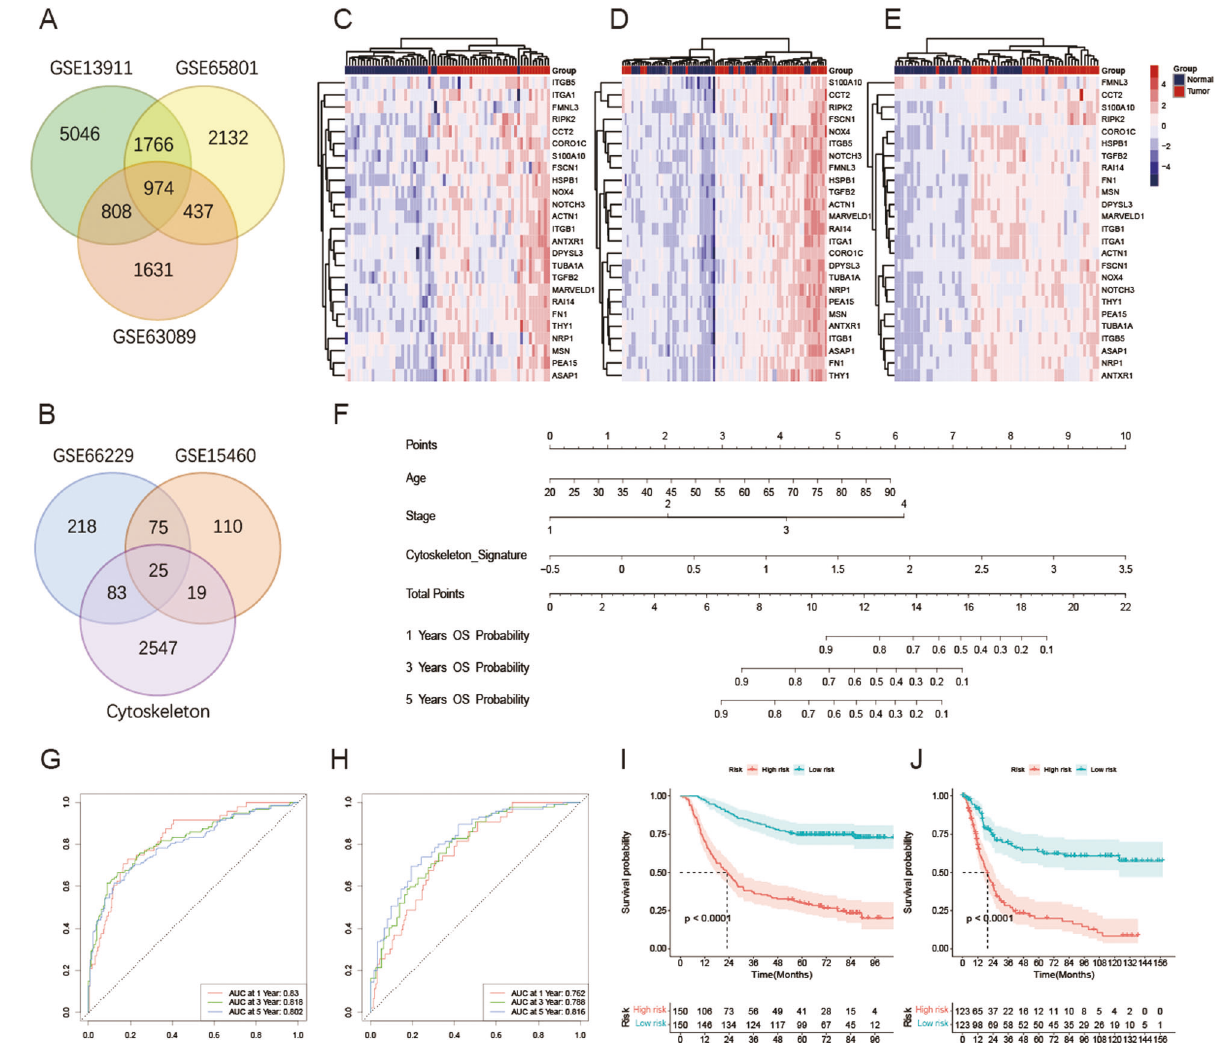
Fig. 1 Extraction of cytoskeleton-related gene signature and construction of cytoskeleton-related risk scoring model. A Co-differential expressed genes in GSE13911, GSE63089, and GSE65801 datasets. B The intersection of survival-associated differential-expressed cytoskeleton-related gene signatures in GSE66229 and GSE15460 datasets. Expression pro fi le of 25 survival-associated cytoskeleton-related gene signatures in GSE13911 ( C ), GSE63089 ( D ), and GSE65801 ( E ) datasets. F Cytoskeleton-related risk scoring model constructed for predicting the overall survival of patients with GC. Receiver Operator Characteristic (ROC) curve of cytoskeleton-related risk scoring model predicting the 1-, 3-, and 5-year overall survival of GC patients in the training ( G ) and validation ( H ) cohort. Kaplan – Meier analysis for GC patients between high- and low- cytoskeleton-related risk groups in the training ( I ) and validation ( J ) cohort. ns-not signi fi cant; * p < 0.05; ** p < 0.01; *** p <